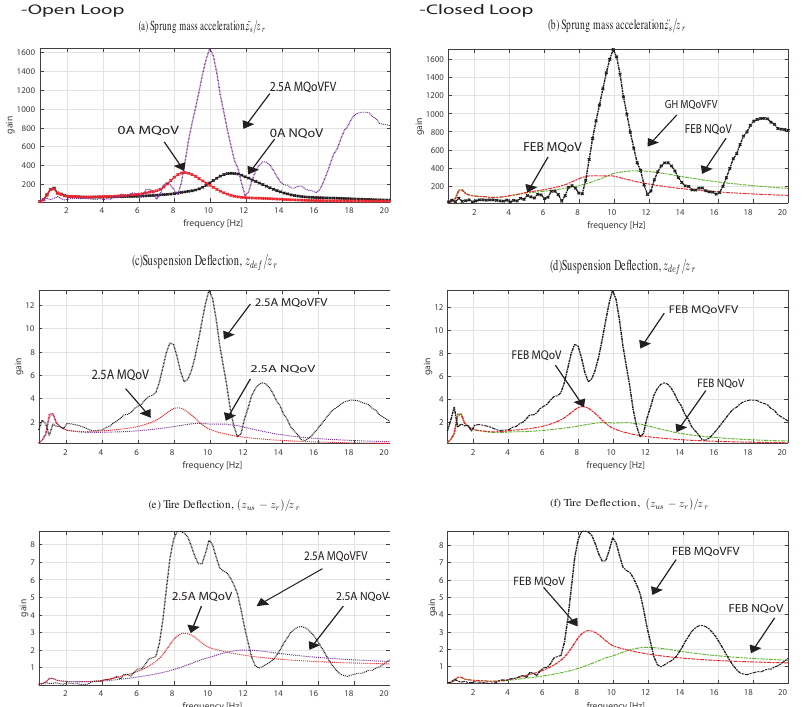
Figure 19. Pseudo-Bode best cases for transfer functions in open and closed loop simulation considering a 1.25 A baseline suspension for the three